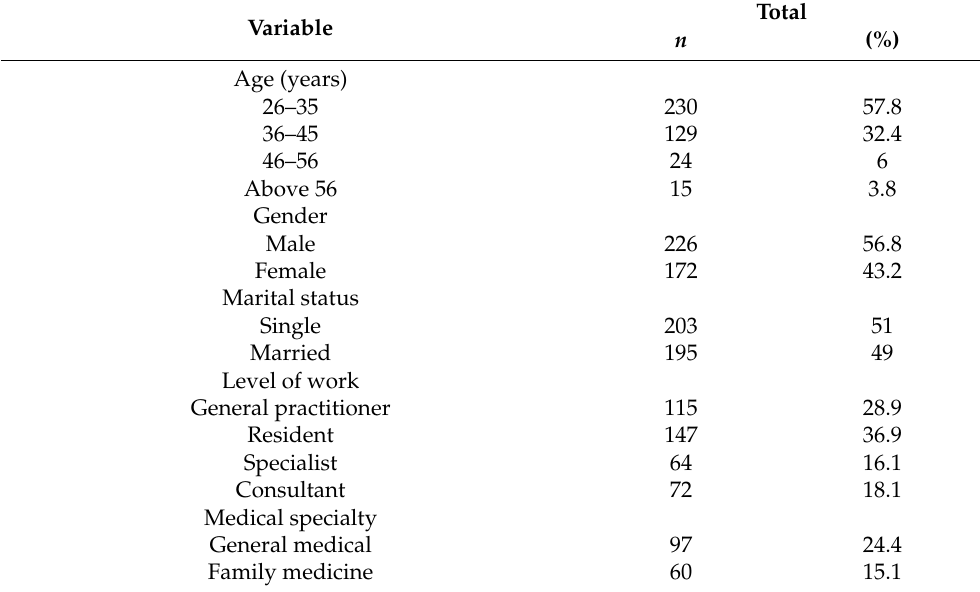
Table 1. Sociodemographic characteristics of physicians who participated in the study ( n =